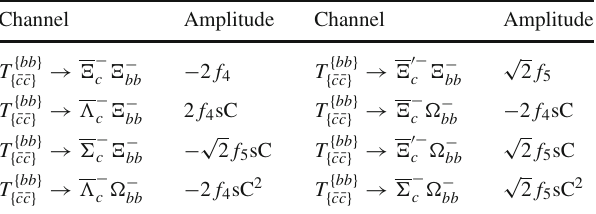
Table 10 Tetraquark T decays into three mesons for the transition ¯ c → ¯ q 1 q 2 ¯ q 3 . In particular, the amplitudes are shown as Cabibbo allowed, singly Cabibbo suppressed, doubly suppressed respectively